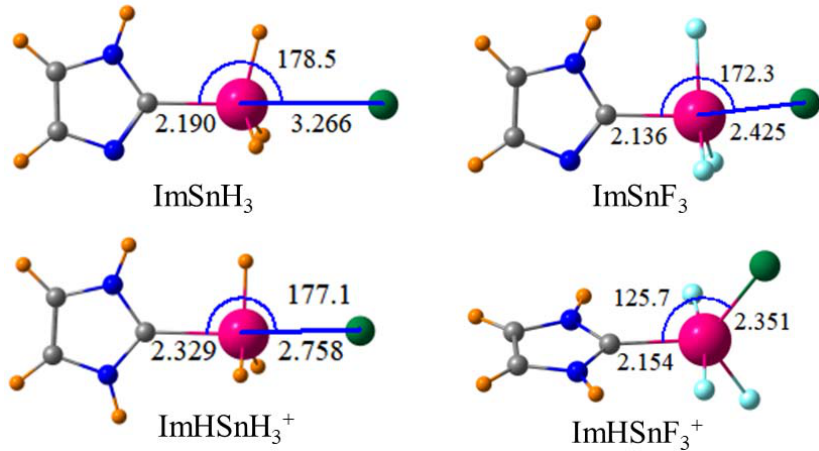
Figure 1. Geometries of indicated Lewis acids with Cl − . Distances in Å, angles in degs.